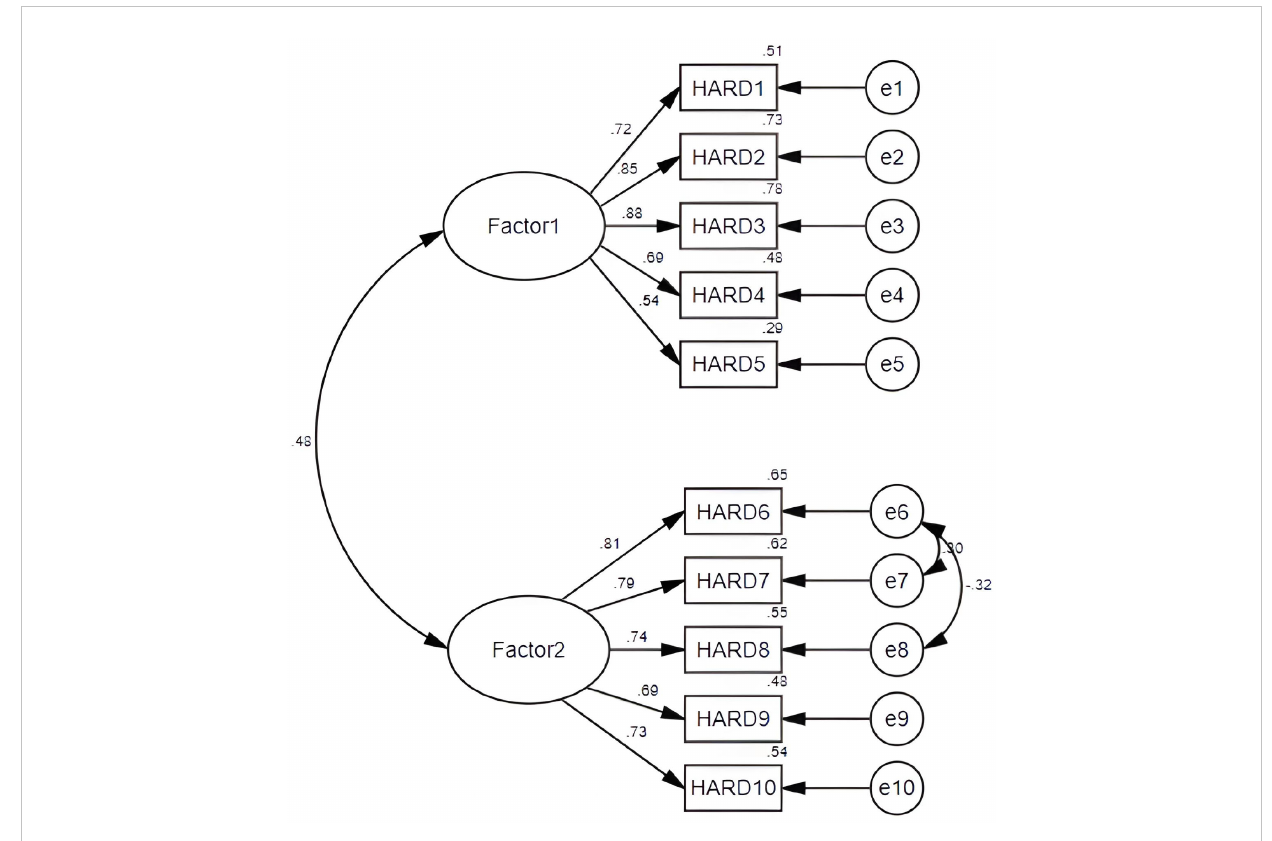
FIGURE 3 A two-factor model for the HARD from con fi rmatory factor